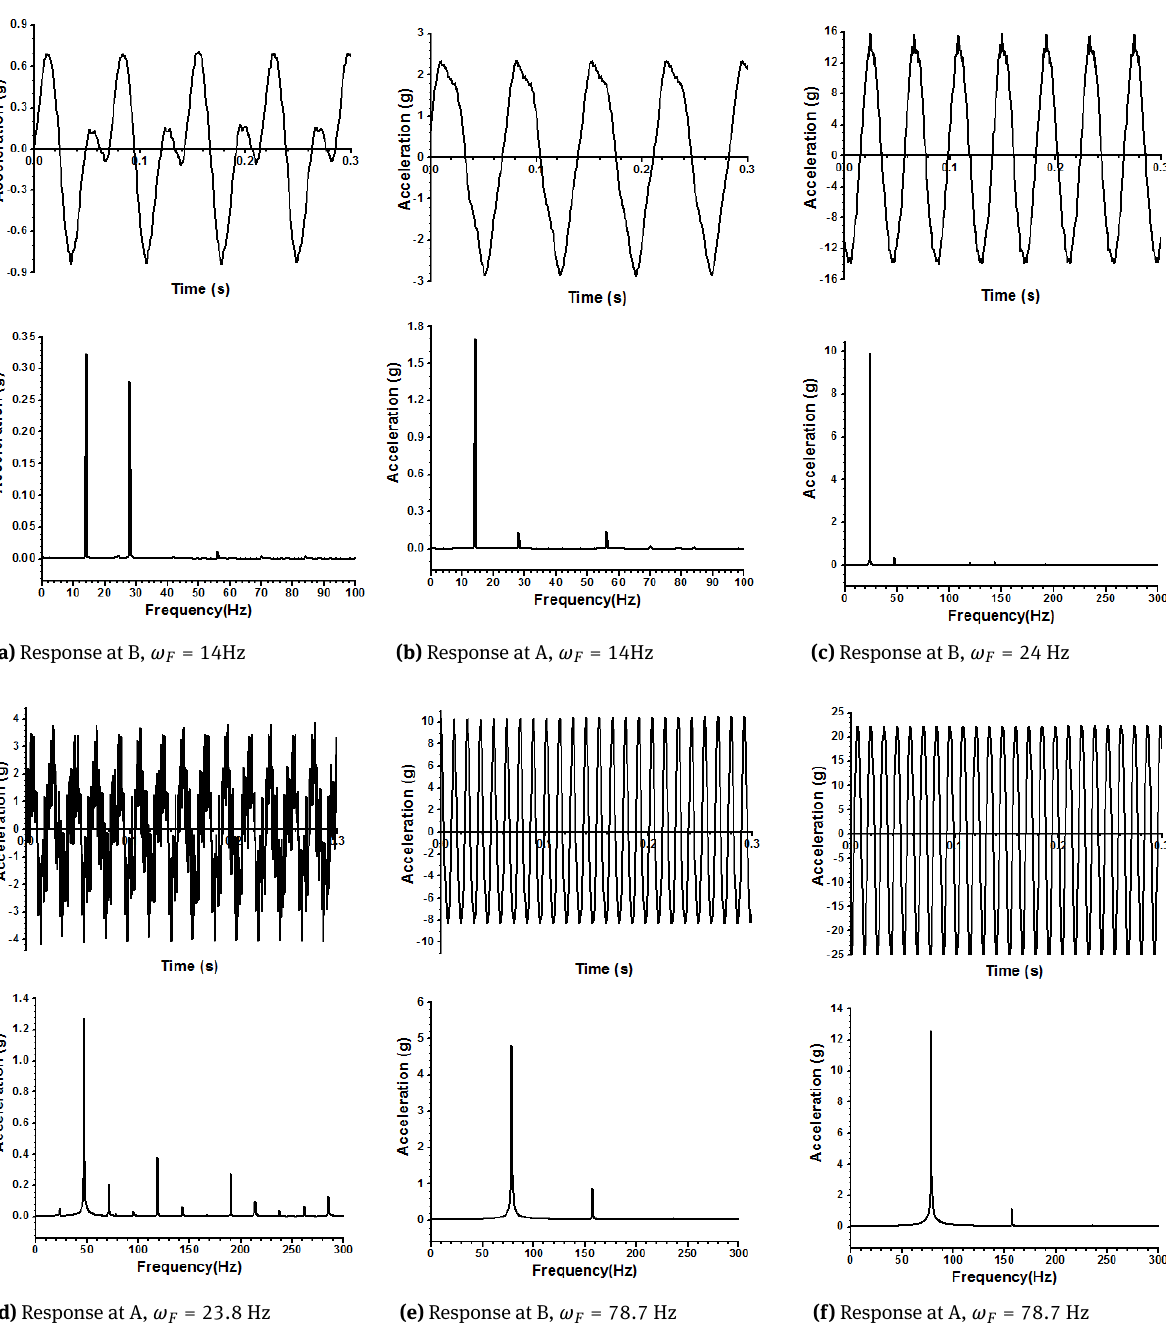
Figure 9: Steady state response history and frequency spectrum of curved beam of span angle 130 ∘ excited at location B (excitation ampli- tude = 1.5